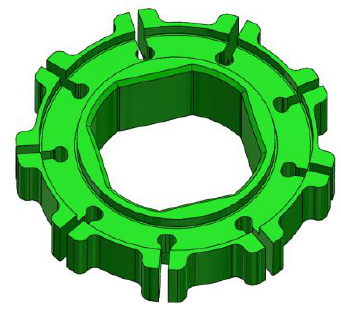
Figure 14. A rotor with variable diameter.